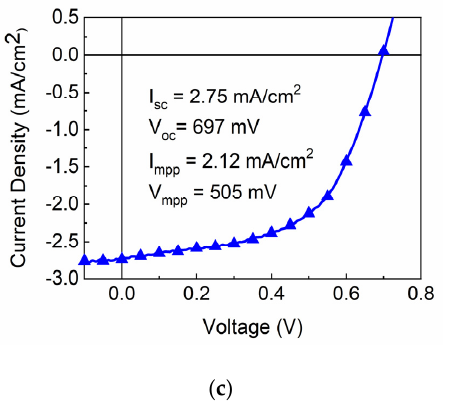
Figure 7. The Bi 2 Se 3 -based organic optoelectronic device. ( a ) Schematic diagram of the device structure; ( b ) energy band alignment; ( c ) I – V characteristics.